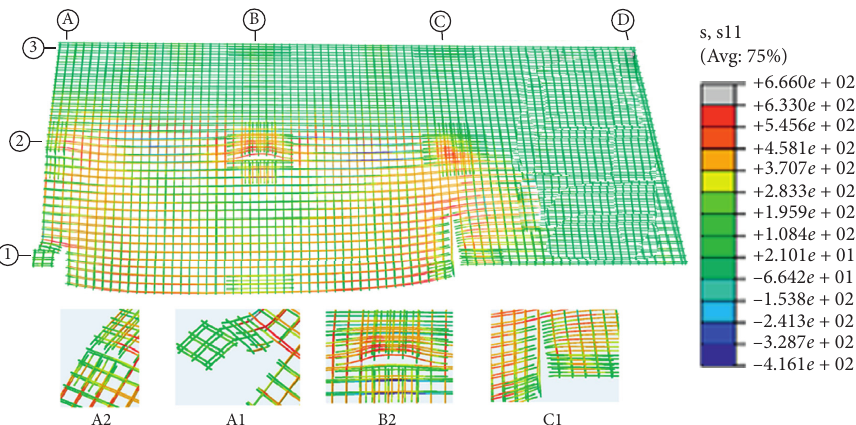
Figure 9: Stress state of the slab bars at station E in model